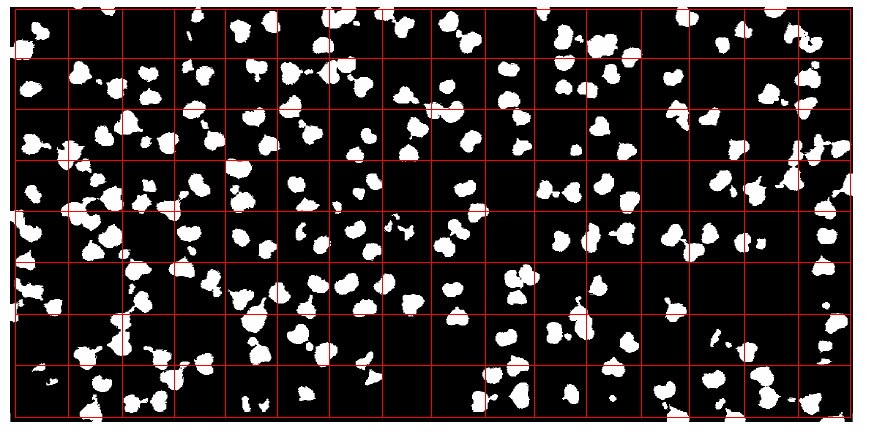
Figure 2. Seedling binary and tray frame image.